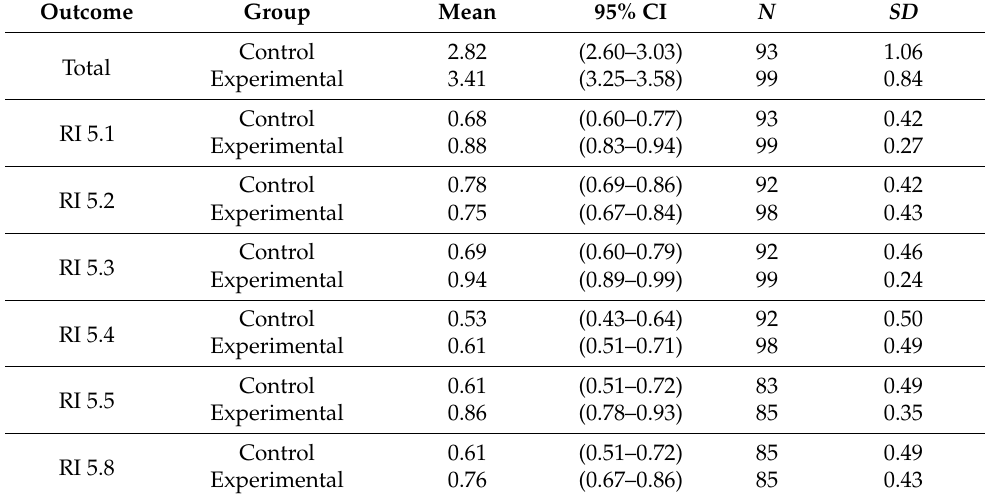
Table 3. Descriptive Statistics for the Outcomes by Experimental Group. N represents the total number of responses toward each outcome not separated out by passage.